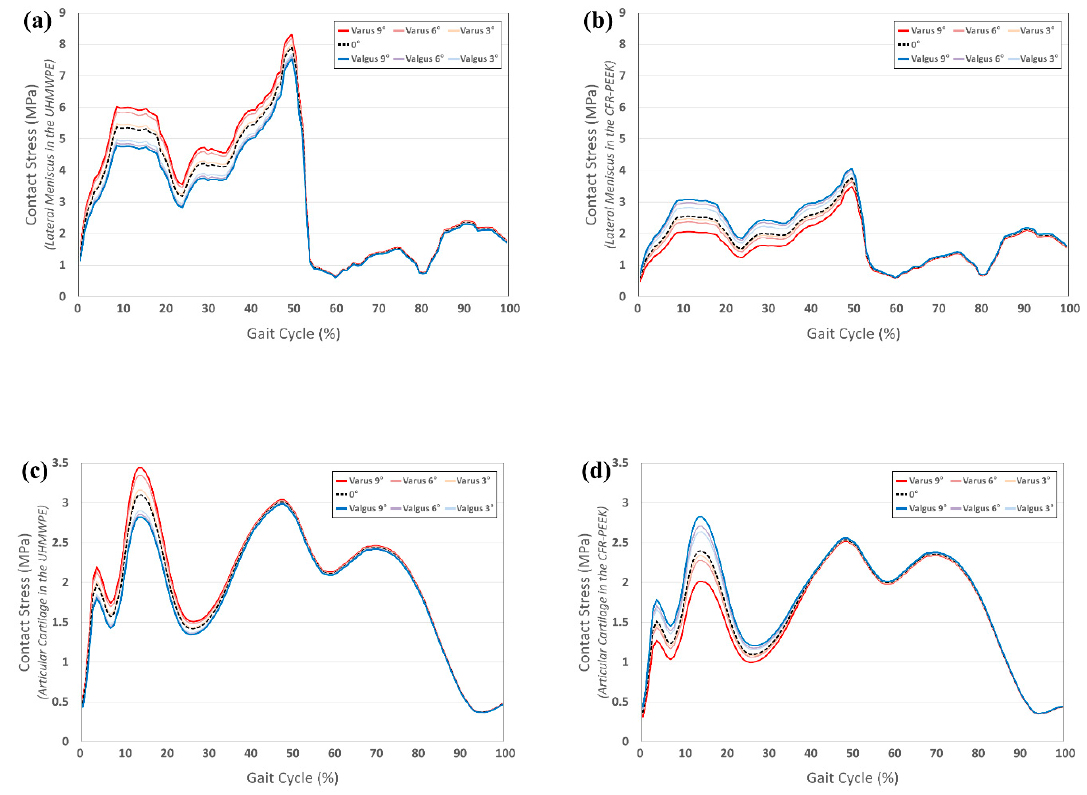
Figure 5. Comparison of contact stress on other compartments in varus/valgus condition with respect to different tibial insert materials during gait cycle: ( a ) lateral meniscus in the ultra-high molecular weight polyethylene (UHMWPE); ( b ) lateral meniscus in the carbon-fiber reinforced polyetheretherketone (CFR-PEEK); ( c ) articular cartilage in the UHMWPE; and, ( d ) articular cartilage in the